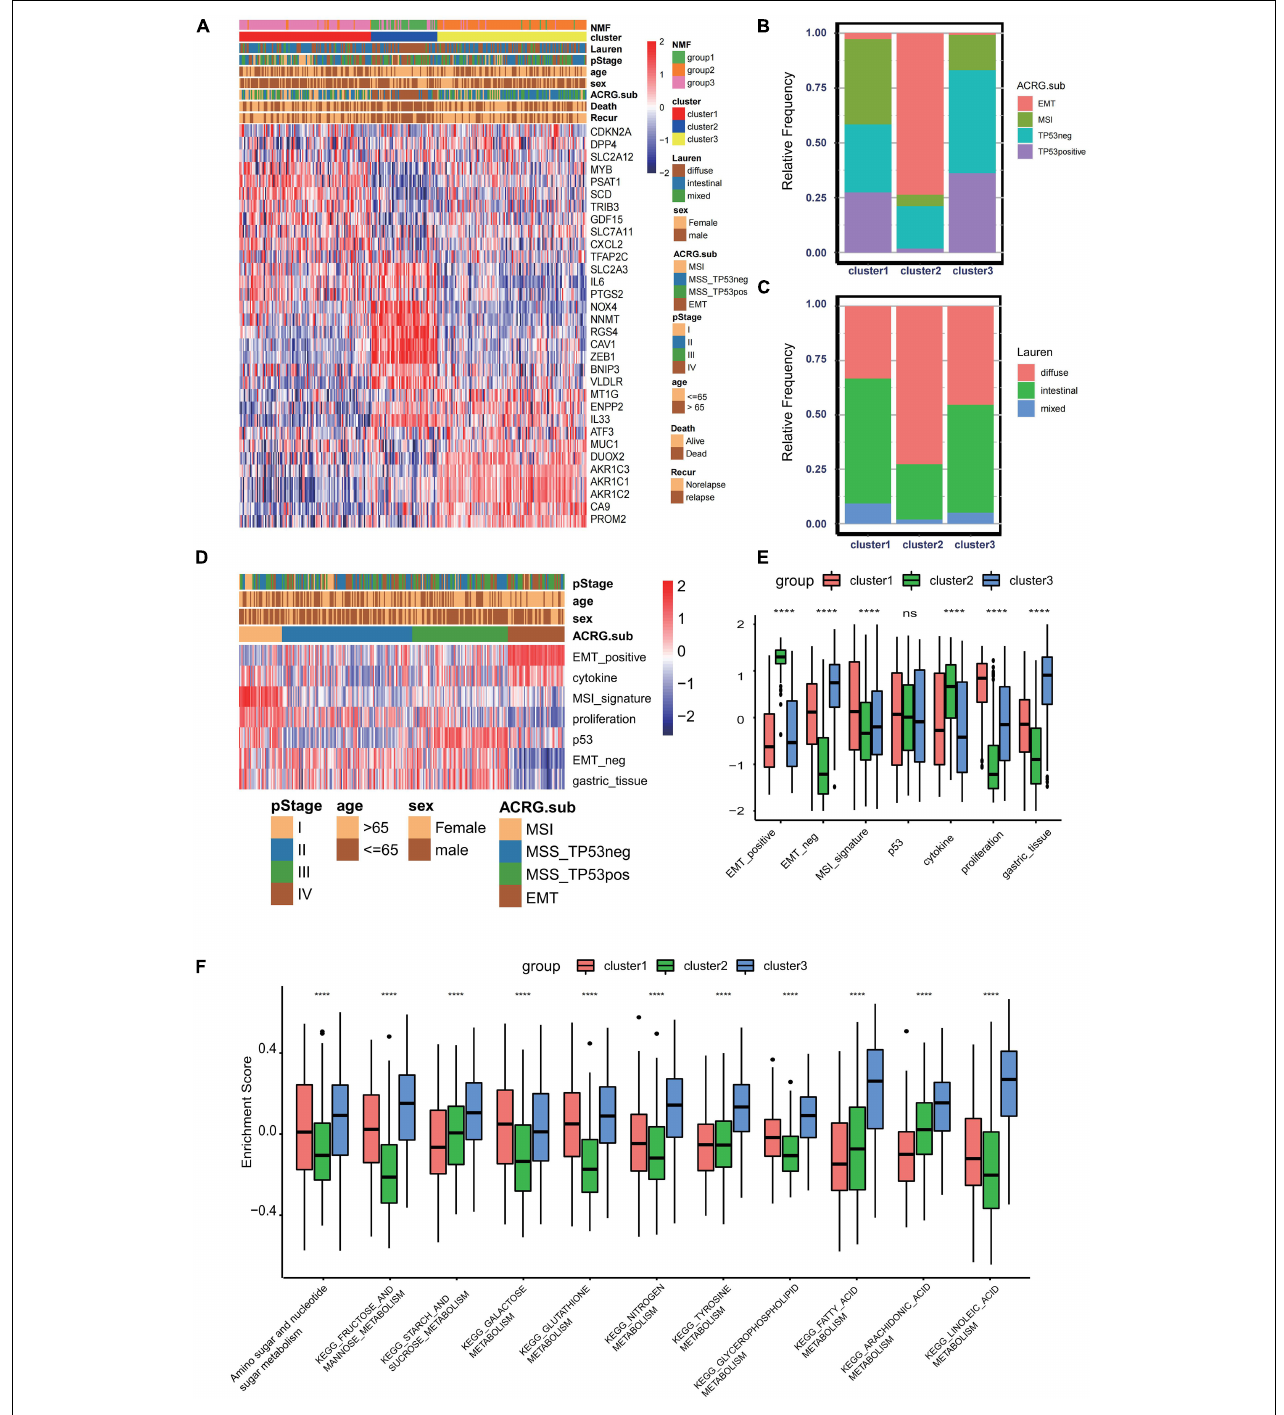
FIGURE 3 | Association between consensus gastric cancer molecular subtypes and the ferroptosis-related clusters. (A) Expression profiles of the 32 ferroptosis-related genes in the Asian Cancer Research Group (ACRG) cohort. The ferroptosis-related clusters, ACRG molecular subtypes, histology subtype, tumor stage, survival status, relapse status, gender, and age were used as patient annotations. (B) Relative frequency of the ACRG molecular subtypes in the three clusters. (C) Relative frequency of Lauren’s histological subtypes in three clusters. (D) Biological characteristics of each ACRG molecular subtype shown in heatmaps. (E) Different activation status of the gene signatures characterized by distinct ACRG molecular subtypes in ferroptosis clusters. **** p < 0.0001). ns , no significance. (F) Different enrichment status of numerous metabolism pathways in the Kyoto Encyclopedia of Genes and Genomes (KEGG) database in three distinct ferroptosis clusters (**** p < 0.0001). ns , no significance.